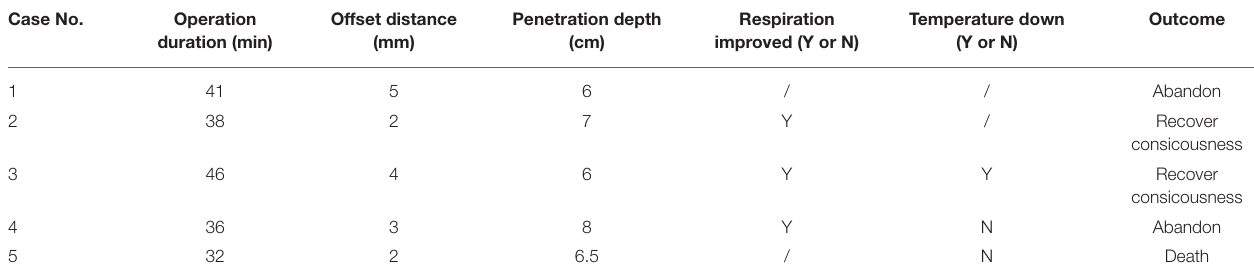
TABLE 2 | Surgical information and postoperative patient outcomes. Case